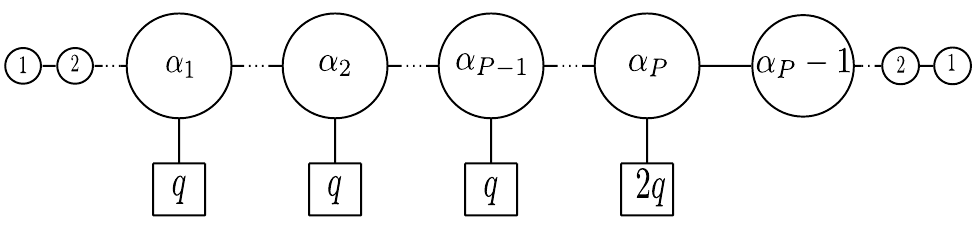
Figure 6 . 2d quiver associated to the brane set-up depicted in figure 5. Circles denote (4,4) vector multiplets and black lines (4,4) bifundamental hypermultiplets. The gauge groups with ranks α , k with k = 1 , . . . , P − 1 to the left of the gauge group with rank α have U(1) flavour symmetries. P The gauge group with rank α has U(2) flavour symmetry. The rest of gauge groups do not have P attached any